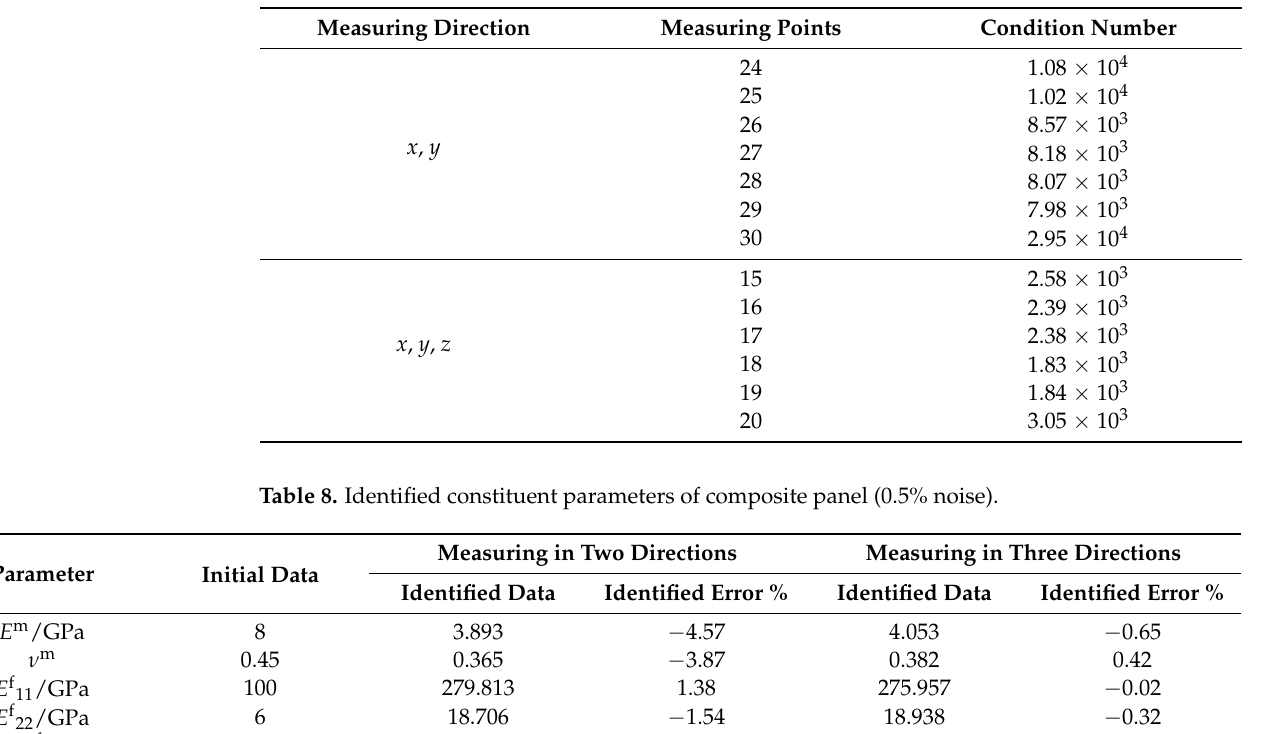
Table 7. Condition number of relative sensitivity matrix for solid model.